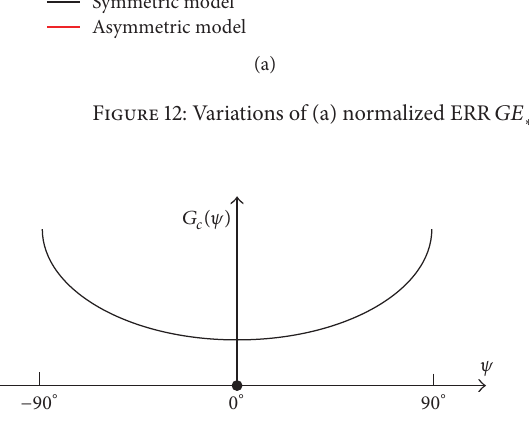
Figure 13: Variation of 𝐺 𝐶 (𝜓) with 𝜓 for the typically elliptic rule fracture